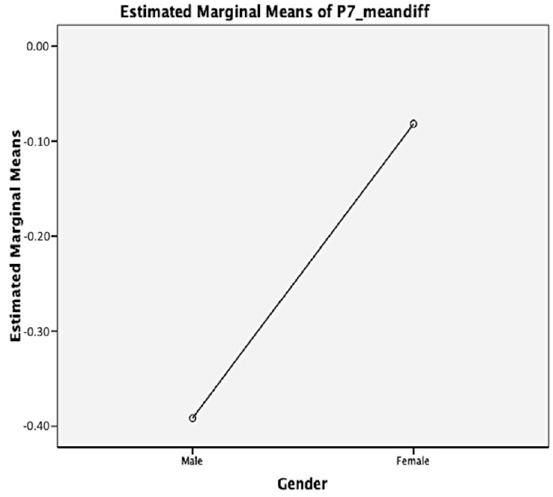
Figure 2. Post-Self–efficacy Scores in Learning Curriculum Subjects through Video Exercises of the Experimental Group.